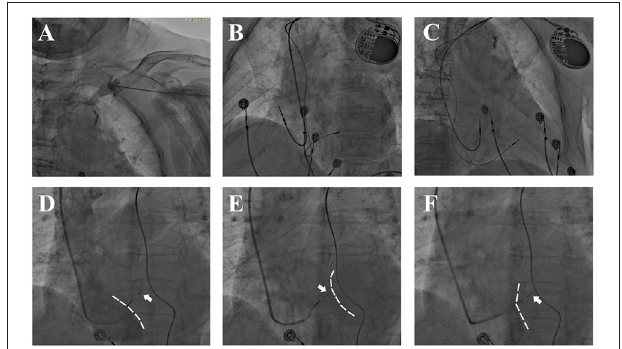
FIGURE 1 | Fluoroscopy during LBBP. (A) Venous angiography after puncture showed a tortuous left subclavian vein. (B,C) Postprocedural fluoroscopy showed a fixed 3,830 lead in the IVS and atrial lead in right atrial appendage. (D–F) Lead depth measured by the relative position of 3,830 electrode ( white arrow ) and IVS during screwing. (D,E) Angiography via 8.5F puncture sheath delineated RV silhouette [ (D) , dashed white line ] while delayed contrast delineated LV silhouette [ (E) , dashed white line ]. (F) Angiography via C315 sheath showed RV side of IVS ( dashed white line